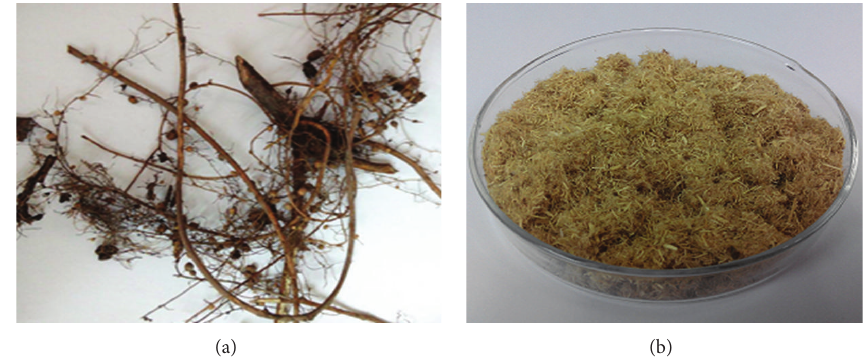
Figure 2: (a) Derris elliptica roots and (b) ground fine roots.